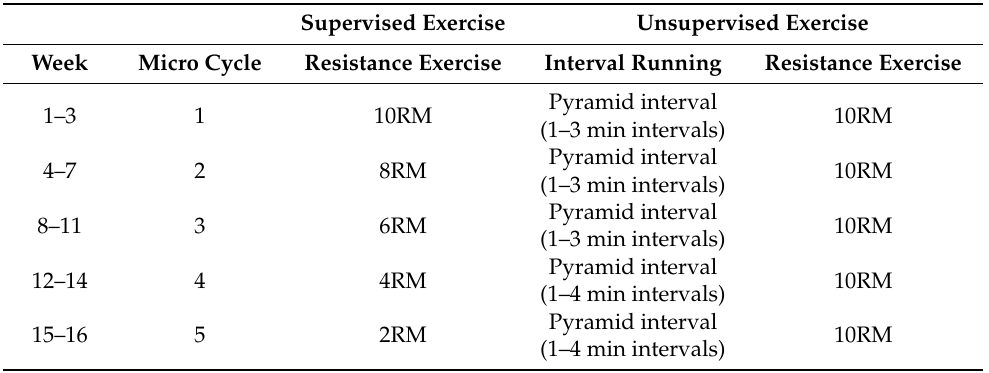
Table 1. Overview of the exercise module of the PED-t treatment. Resistance load is given as number of repetition maximum